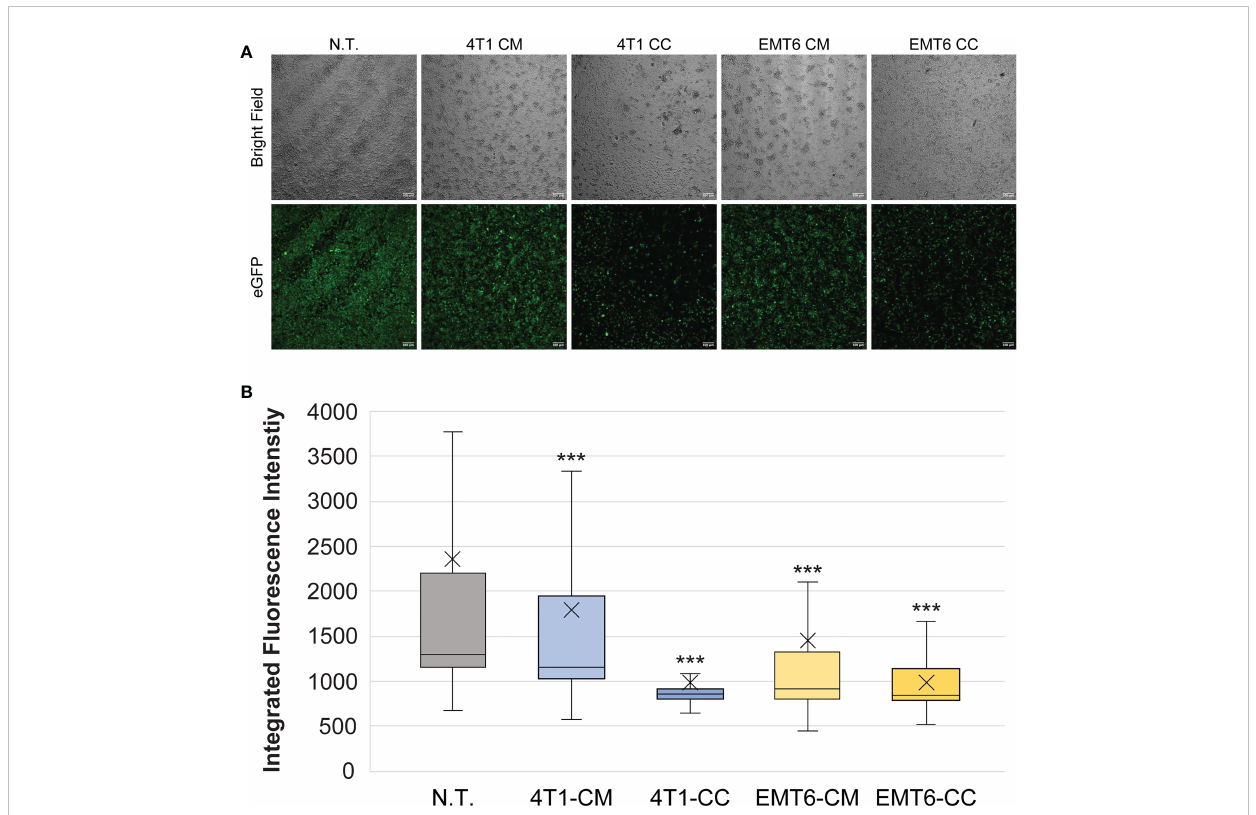
FIGURE 2 Macrophage exposure to conditioned media (CM) from or co-culture (CC) with 4T1 or EMT6 cells. (A) Confocal microscopy images of RAW: iNos - eGFP cells following exposure to conditioned media from 4T1 or EMT6 cells or subjected to co-culturing with each. eGFP=enhanced green fl uorescent protein. Diminished fl uorescence relative to non-treated (N.T.) is observed for all treatments, to different extents based on cell and model type. Scale bars on confocal images represent 100 µm. (B) Per-cell fl uorescence intensity quanti fi cation of images shown in (A) . The “ x ” in the box represents the mean; the bottom and top lines of the box represent the median of the bottom half (1st quartile) and median of the top half (3rd quartile), respectively; the line in the middle of the box represents the median; the whiskers extend from the ends of the box to the minimum value and maximum value. Student ’ s T-test was used for statistical analysis versus N.T. (n = 1,422) (p<0.001 = ***). Student T-test comparing 4T1-CM (n = 968) versus 4T1-CC (n = 370) and EMT6-CM (n = 581) versus EMT6-CC (n = 336) shows statistical signi fi cance